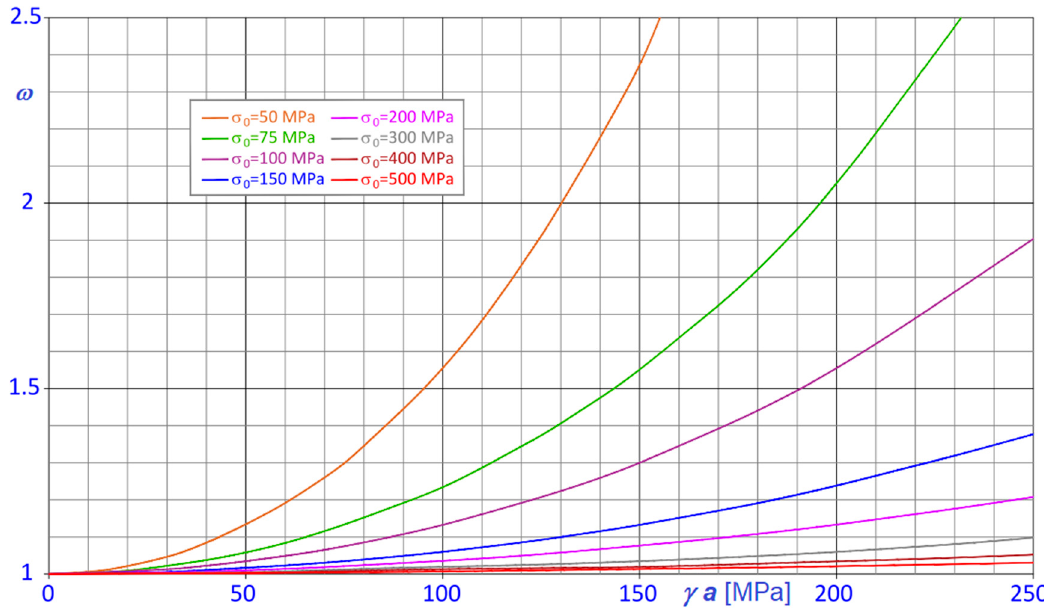
Figure 5. 𝜔 − 𝛾𝑎 curves parameterized in terms of horizontal stress component 𝜎 (cid:2868) . Figure 5. ω − γ a curves parameterized in terms of horizontal stress component σ 0